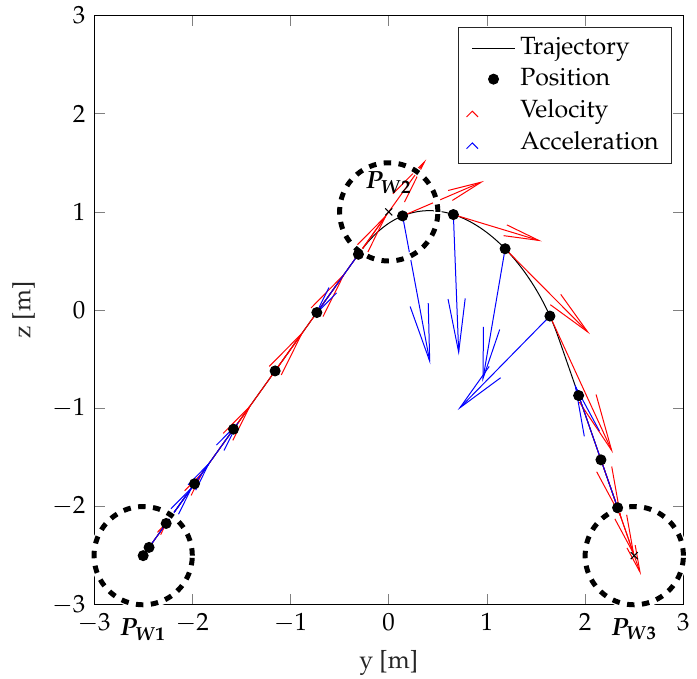
Figure 10. An example of the motion model used with acceleration and velocity shown in the figure. Waypoints are denoted by P W and the acceptance circles are marked with a dotted